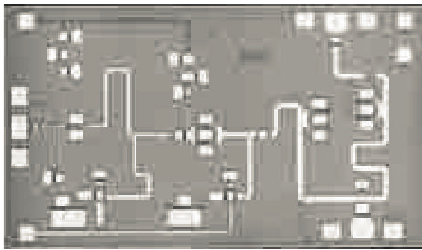
Figure 7: The illustration of packaged DUT.